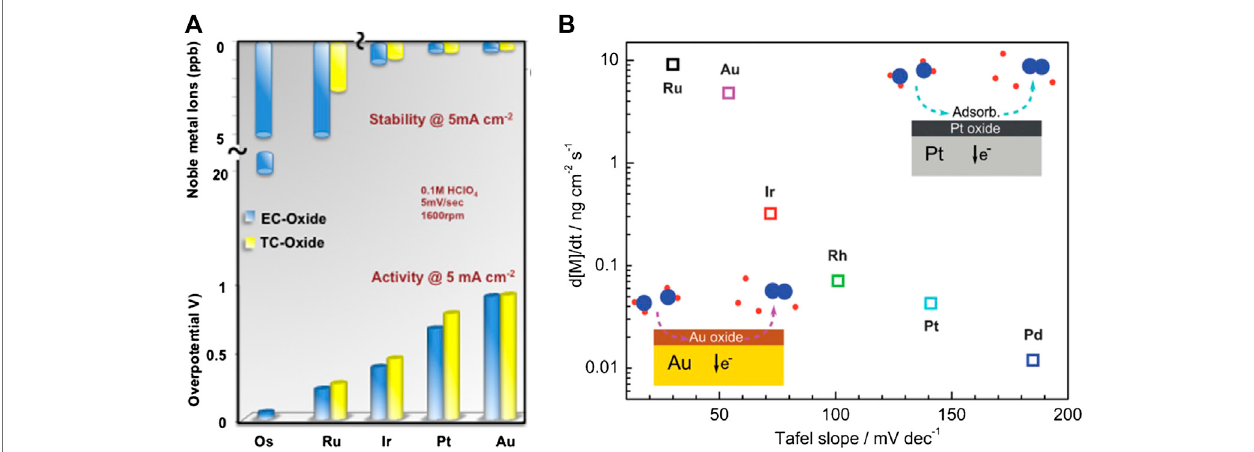
FIGURE 3| (A) Activity – stability relation for fi ve oxidized noble metals and four thermallyprepared oxidesin 0.1 M HClO 4 used aselectrolyte, at 1600 rotations per minute(rpm),atscanrateof5 mV/secatgalvanostaticregimeof5 mA cm − 2 .Overpotentialisgiveninrelation totheamountofdissolvedmetal ions.Reprinted fromRef. Danilovic et al. (2014), with permission from the American Chemical Society. (B) Dissolution rate as a function of the Tafel slope for OER, for sixoxidized noble metals, in 0.1 M H 2 SO 4 measured at galvanostatic regime of 5 mA cm − 2 . Reprinted from Ref. Cherevko et al. (2014c), with permission from